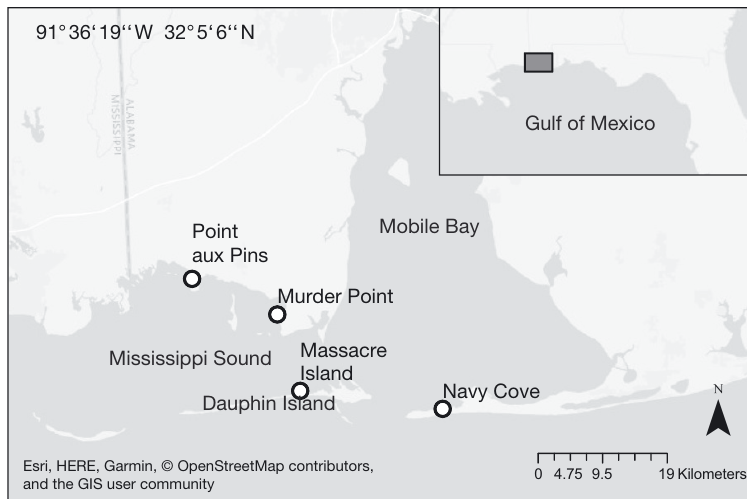
Fig. 2. Study area with oyster farms (white circles) where oysters were